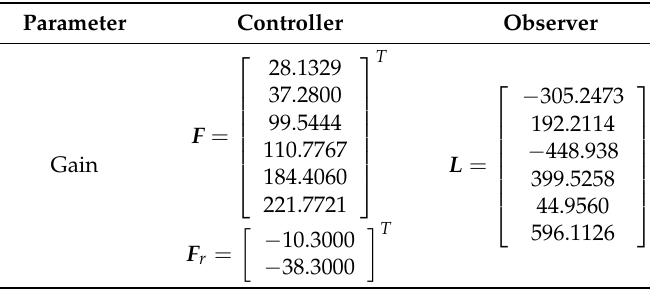
Table 2. Controller and observer gain and parameters.